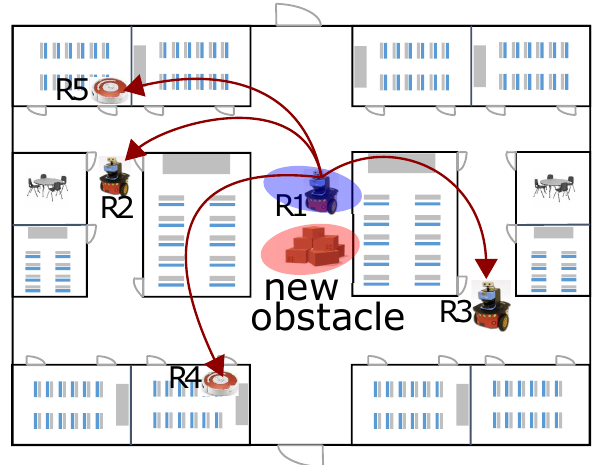
Figure 1. Robot R 1 finds a new obstacle blocking the path and shares this information with other robots (R 1 , · · · ,R 5 ). The blue and red ellipses represents the robot’s and obstacle’s positional uncertainty,